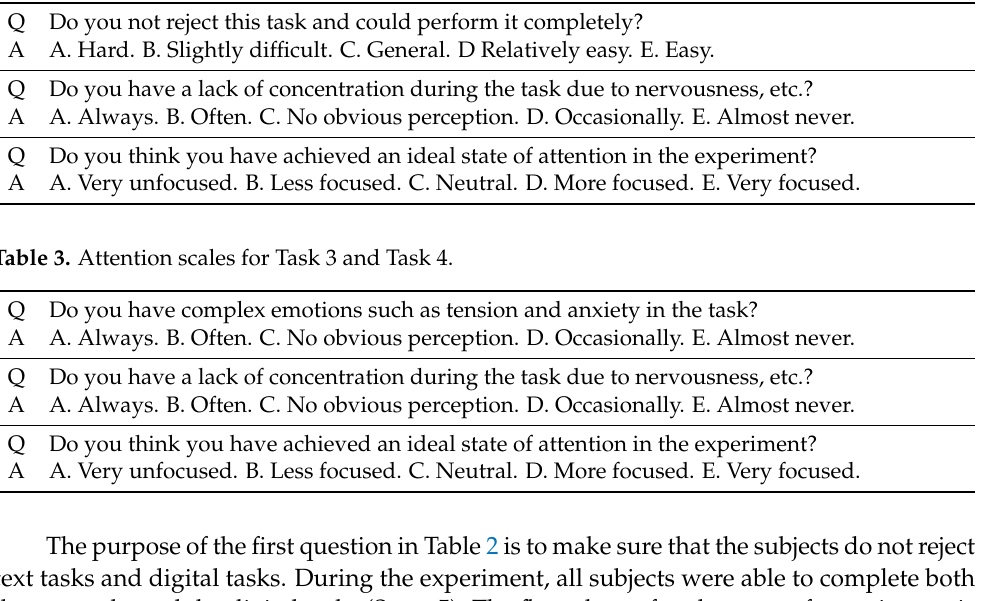
Table 2. Attention scales for Task 1 and Task 2.